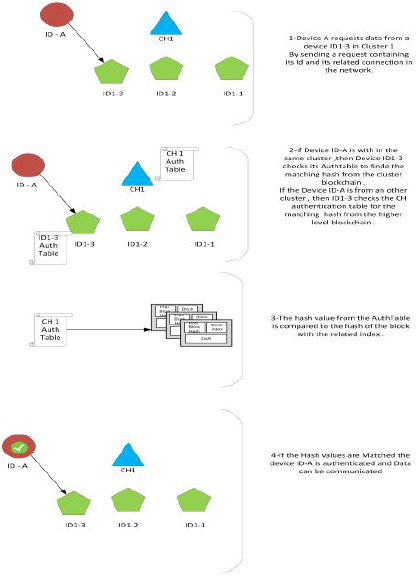
Figure 7. Authentication-Chains authentication process.